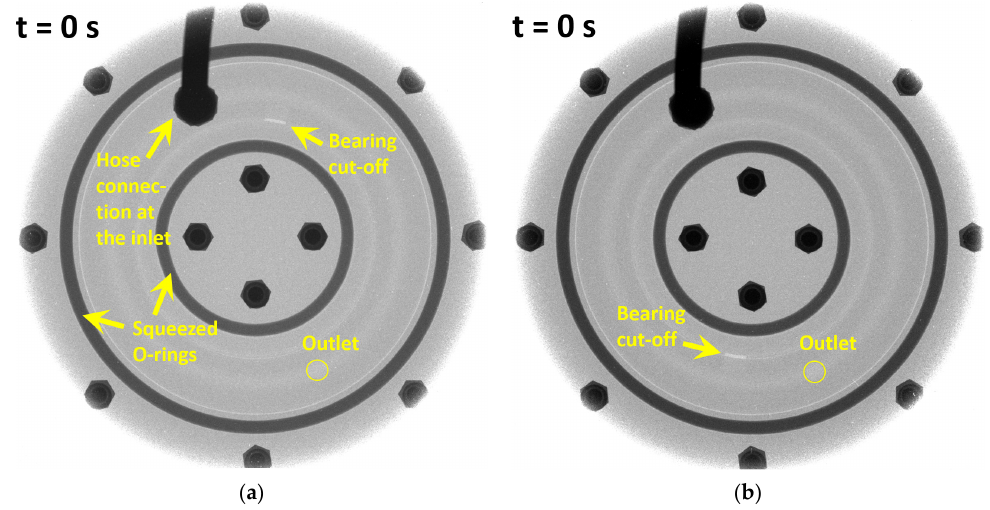
Figure 13. “ Dry” images of the fi lling process. ( a ) Initial NR image of “Top” case; ( b ) Initial NR Figure 13. “Dry” images of the filling process. ( a ) Initial NR image of “Top” case; ( b ) Initial NR image image of “Bo tt om” case. of “Bottom” case.